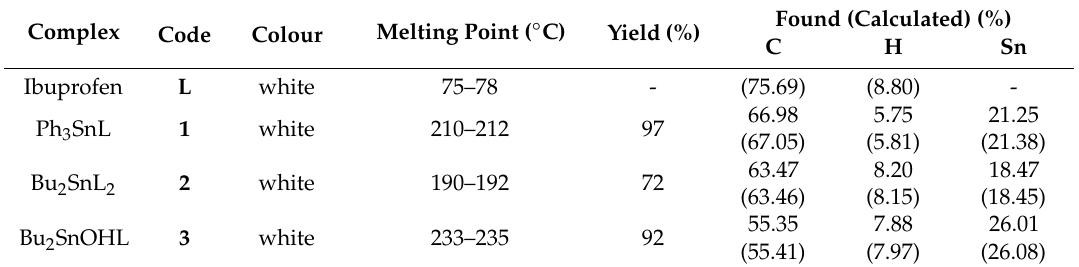
Table 1. Elemental analysis and physical properties of synthesized complexes.